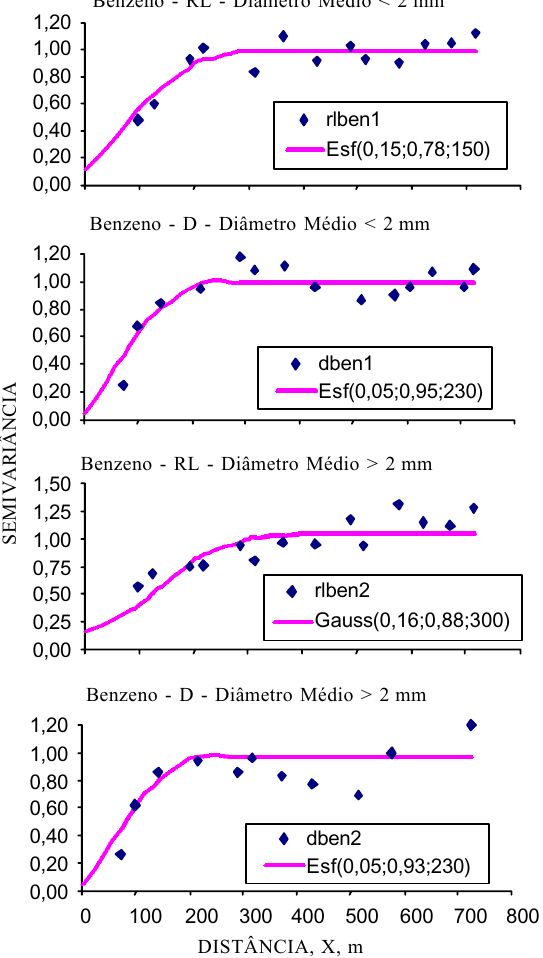
Figura 3. Semivariogramas experimentais para o maior tamanho de agregado - R dimensão da massa fractal D no pré-tratamento com benzeno. Modelos: esférico (Esf) e gaussiano (Gauss)